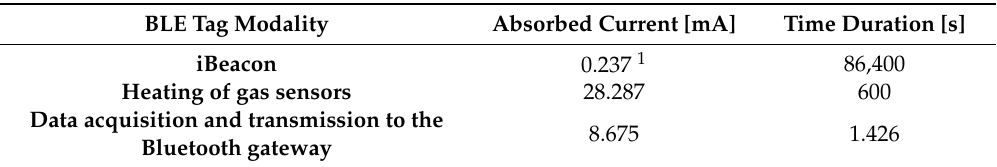
Table 2. Current absorbed by the BLE smart tag during the di ff erent operative phases along with the relative time durations referred to a single operative